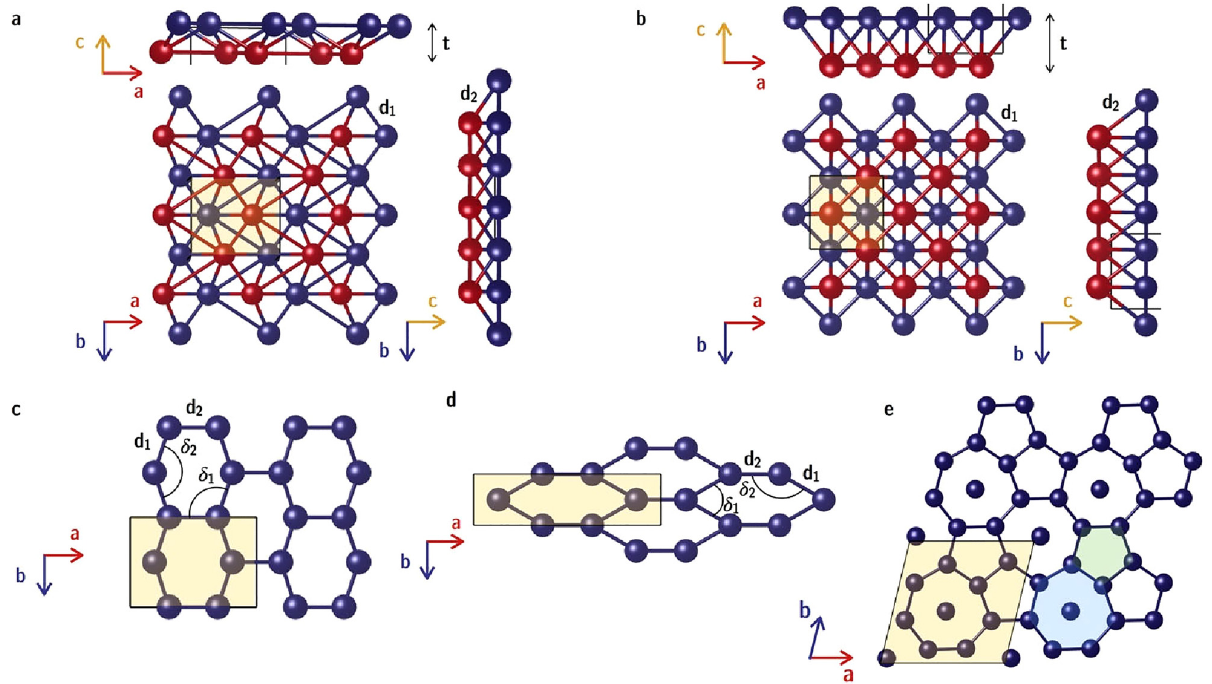
Figure 10: Relaxed structures of the various gallenene phases: (a and b) Perdew – Burke – Ernzerhof (PBE) and PBEsol bilayer gallenene, (c) compressed hexagonal gallenene, (d) elongated hexagonal gallenene, and (e) γ -gallenene. The unit cell is shadowed in yellow. The lattice parameters of each structure are gathered in Supplementary material §7.